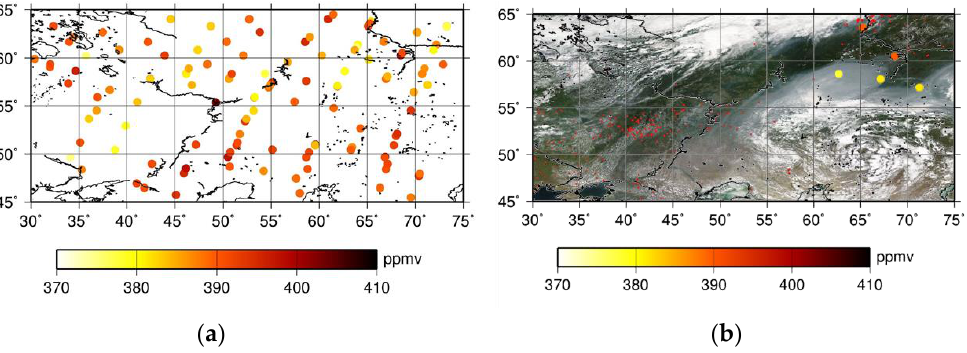
Figure 8. Horizontal distribution of newly retrieved XCO 2 data analyzed using the optimized method for the target dataset ( a ), and an example of a visible composition image of MODIS for a smoky scene and XCO 2 values represented by large colored dots observed on 8 August 2013 ( b ). Red points shown in ( b ) are fire positions detected by MODIS/Terra and Aqua on the day.